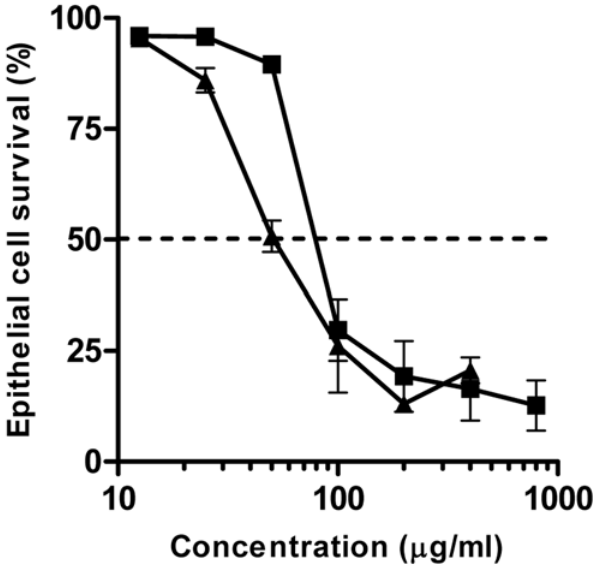
Figure 5. Cytotoxicity of GML and DDG to Human Vaginal Epithelial Cells (HVECs). HVECs were exposed to GML ( & ) and DDG ( m ) for 6 h. Cytotoxicity was accessed by measuring the release of LDH. Error bars are SEM. The dashed line indicates median cell survival (LD 50 ). Symbols: & , GML; m , DDG. doi:10.1371/journal.pone.0007499.g005 PLoS ONE |